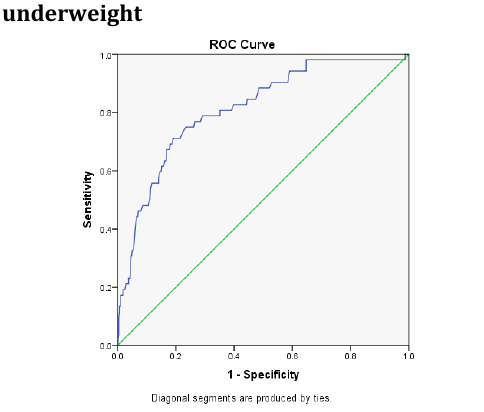
Fig 1c - ROC curve of TSFT in predicting underweight